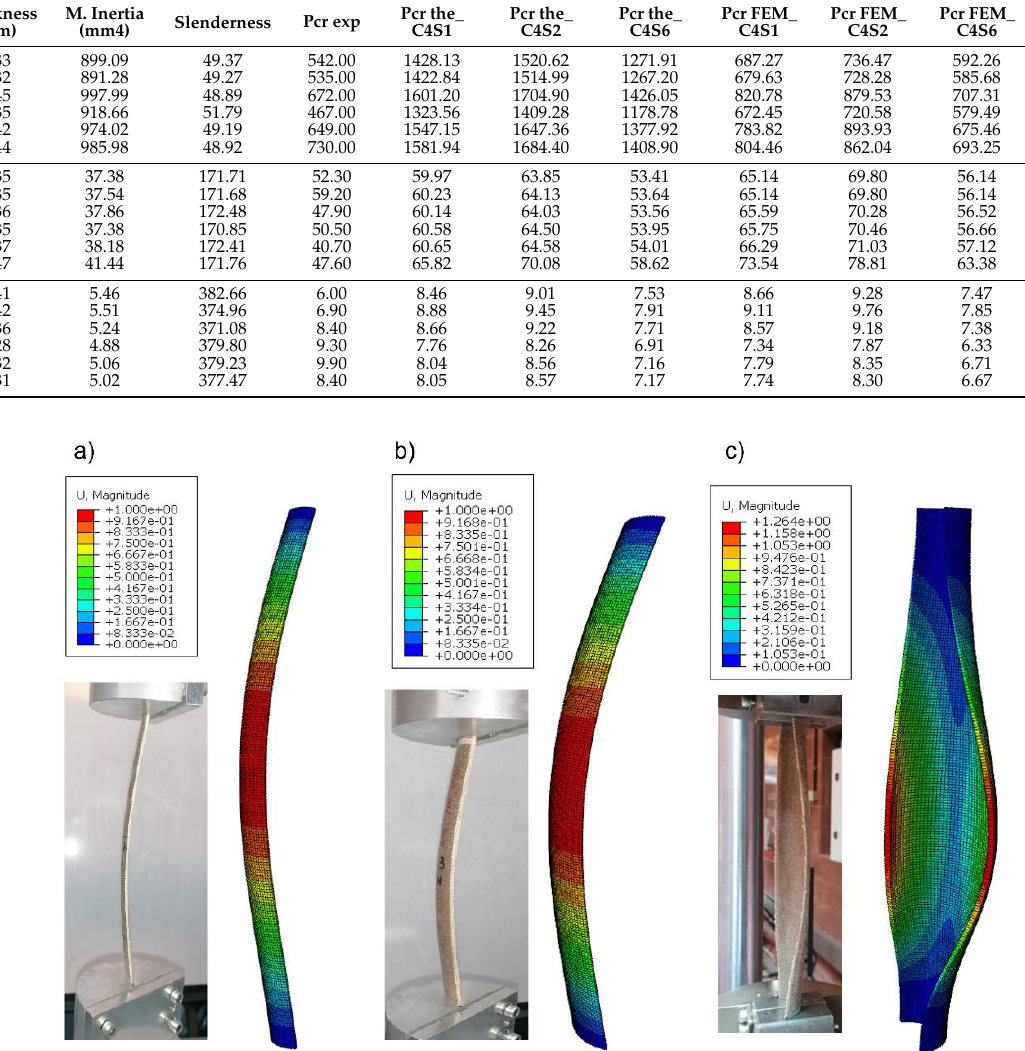
and bottom lines represent the maximum and minimum values, the box limits indicate the upper quartile (Q3) and lower quartile (Q1), the midline represents the median, and the X mark the mean value. Table 2. Critical buckling loads obtained from the three approaches: experimental tests, numerical model and analytical approach.